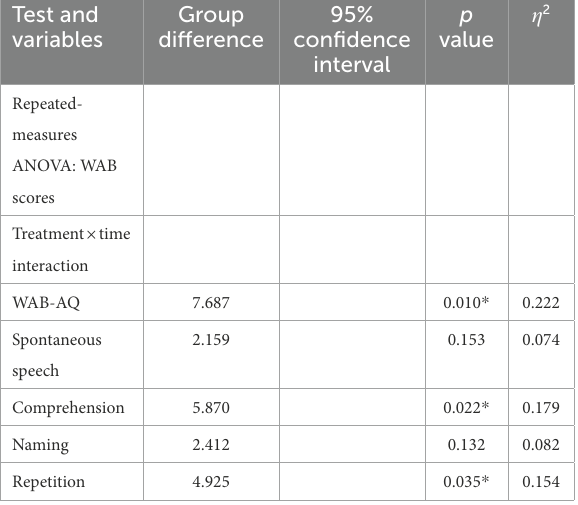
TABLE 2 Statistical data of WAB score changes with pre-and post- treatment between the cTBS group and the sham group. Test and variables